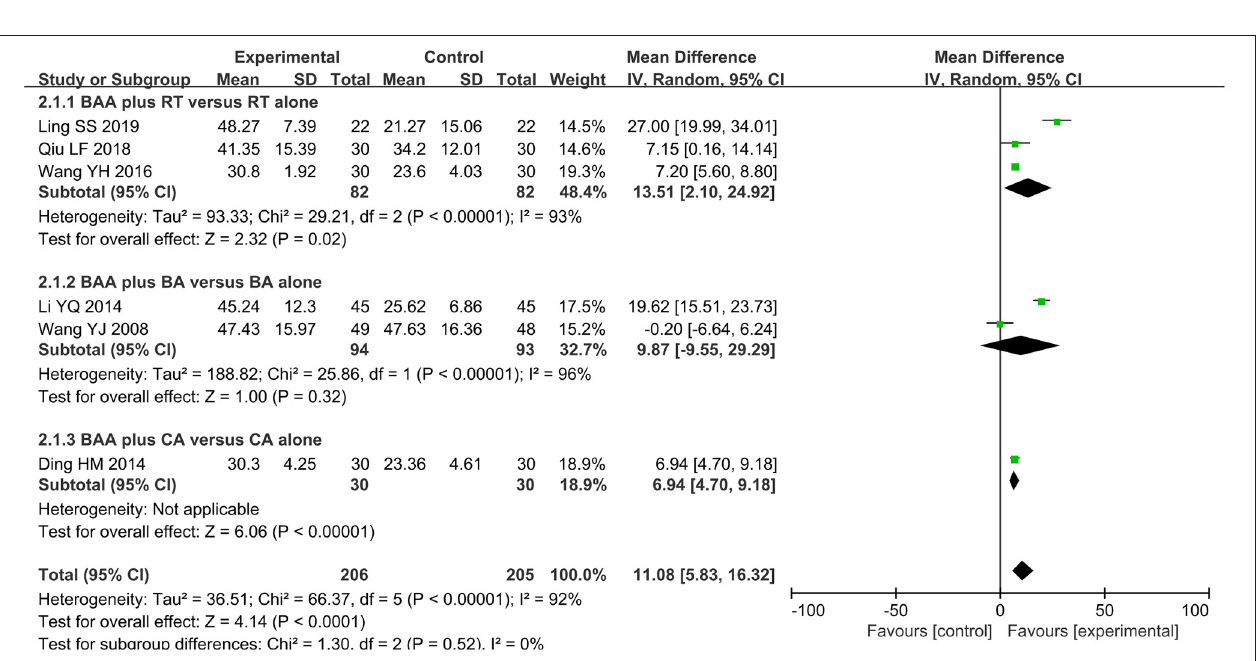
FIGURE 4 | Forest plot and meta-analysis of FMA-U. (BA, body acupuncture; BAA, Bo’s abdominal acupuncture; CA, conventional acupuncture; CI, confidence interval; FMA-U, Fugel-Meyer Assessment Scale for upper extremity; RT, rehabilitation training).